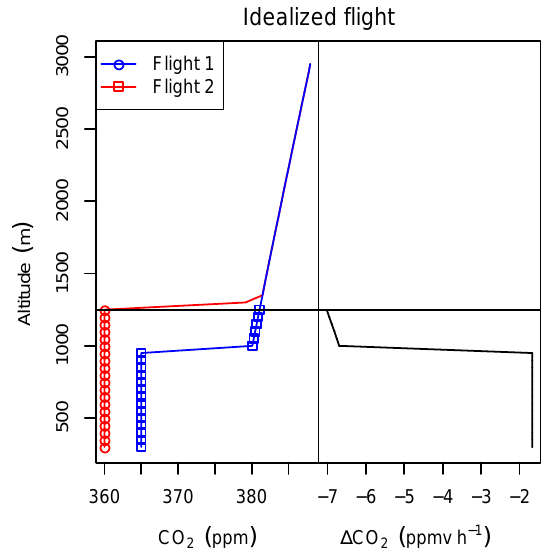
Figure 1. An idealized flight that includes a well-mixed, homoge- neous mixing ratio of carbon dioxide near ground level, then a de- crease in carbon dioxide mixing ratio from the first launch (blue) to second launch (red) corresponding with an increase in the bound- ary layer height. Above the boundary layer height of the second flight, mixing ratios between the flights should match again because ground-level photosynthetic activity does not affect carbon dioxide mixing ratios above this altitude (left panel). Both the decrease in the mixed-layer carbon dioxide mixing ratio and the increase in the boundary layer height contribute to (cid:49) CO 2 , and hence NEE. This idealized picture neglects subsidence and horizontal